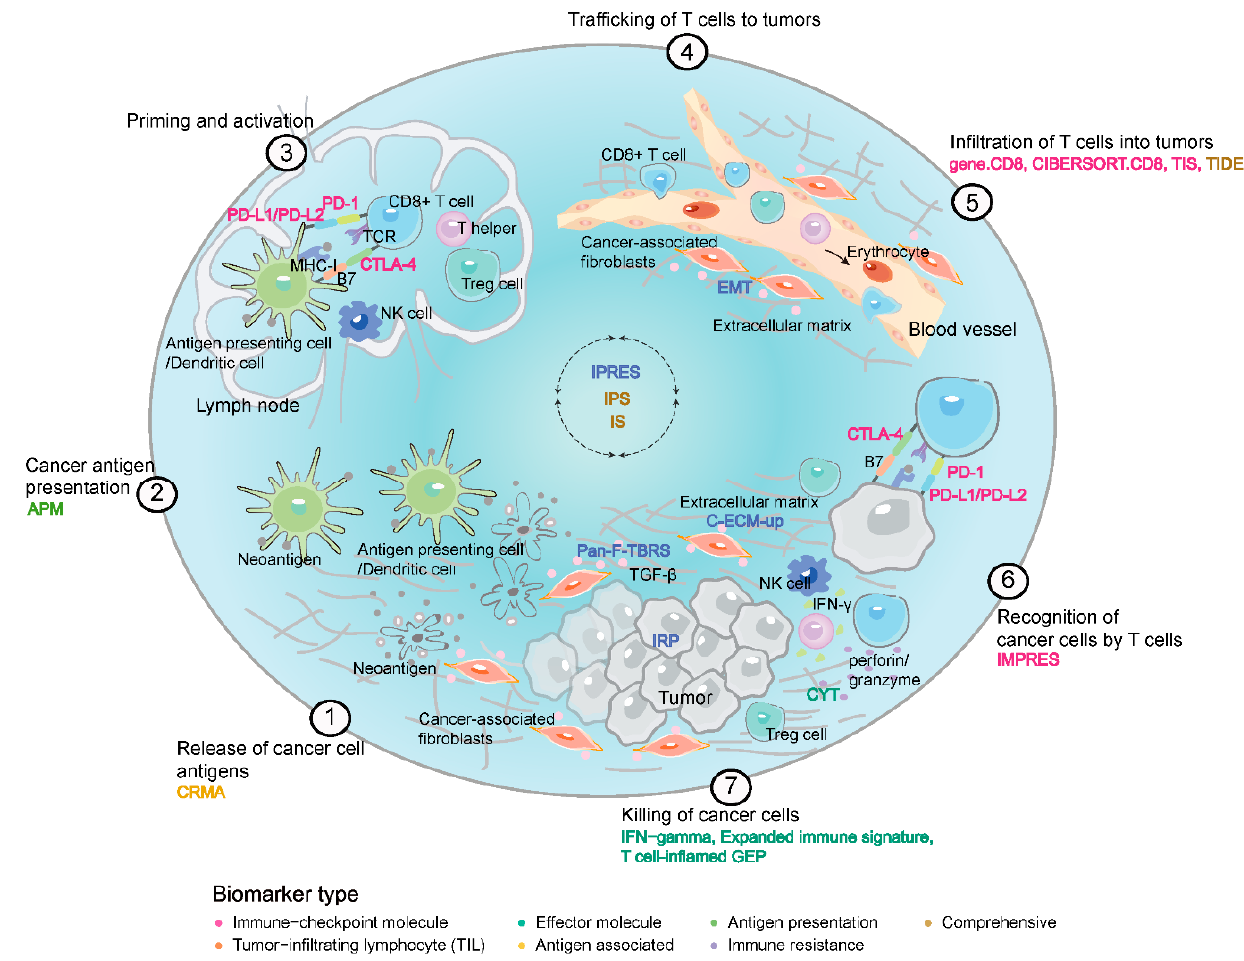
Figure 1. Transcriptomic biomarkers of ICB response in Cancer-immune Cycle.